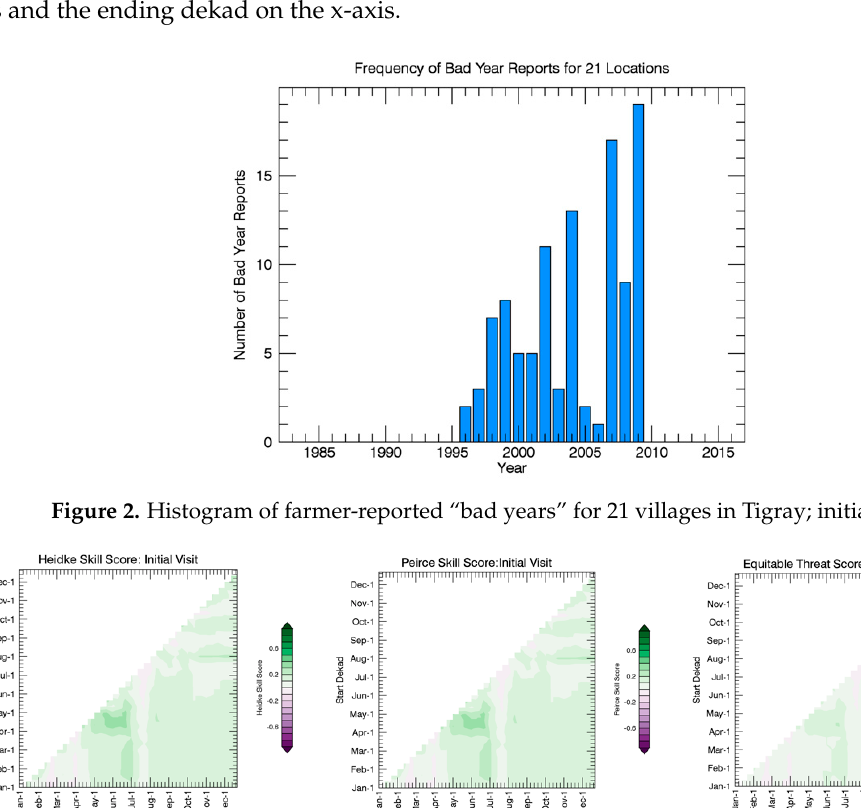
purple indicates an increased number of misses. Plots are arranged with the starting dekad, or 10- day period, on the y-axis and the ending dekad on the x-axis.